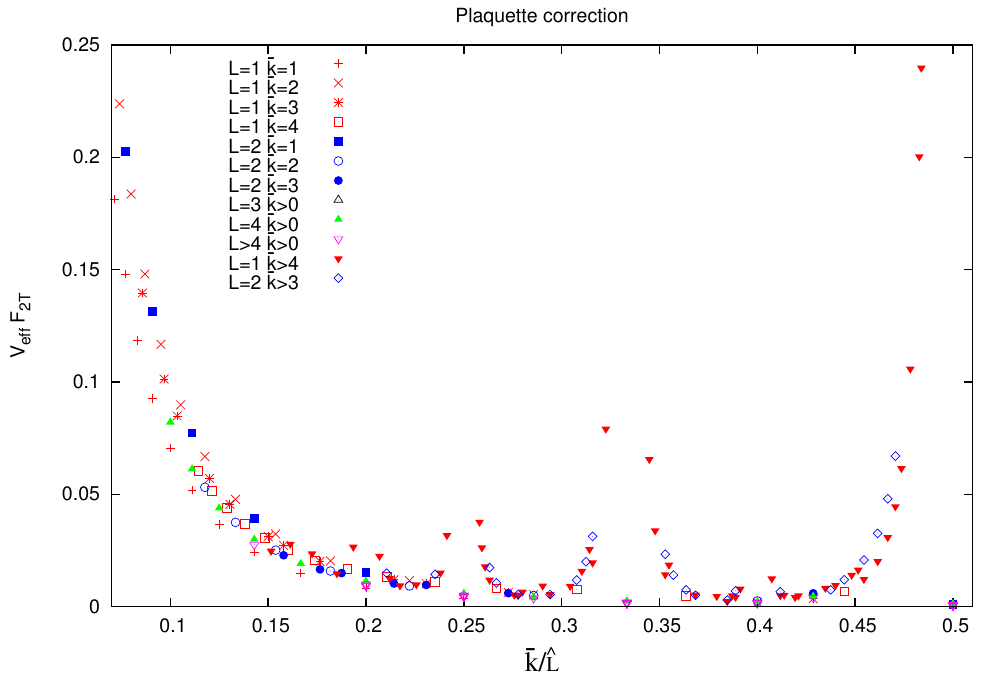
Figure 2. The function V e(cid:11) F 2 T ( L ) for the plaquette is plotted as a function of (cid:22) k= ^ L .